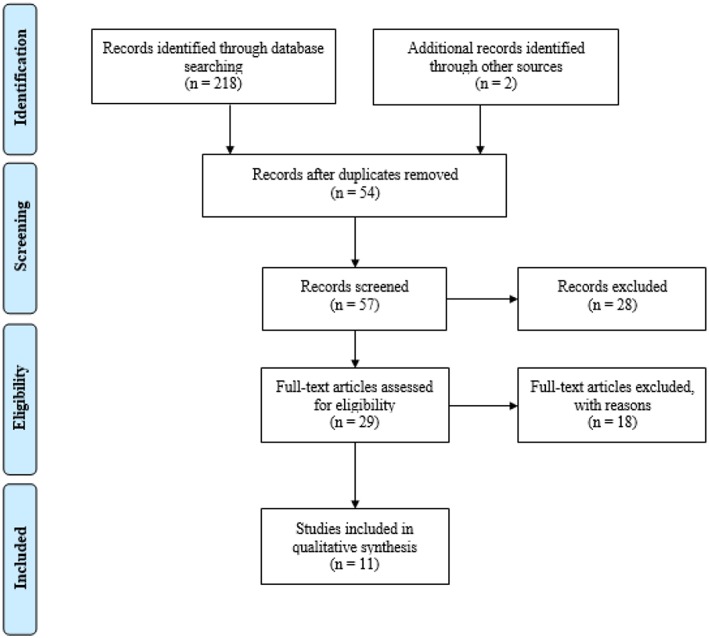
PRISMA Flowchart of the systematic search (Moher et al., 2009).